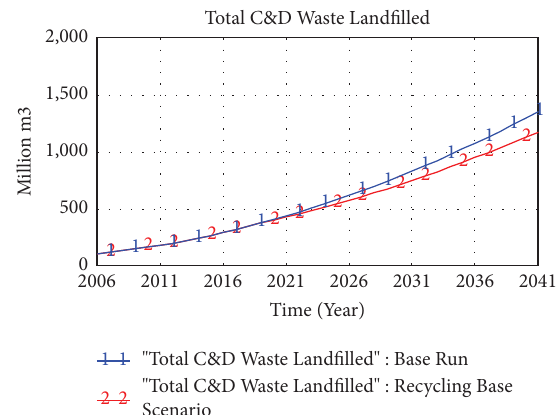
Figure 11: Te trend of landflled C&D waste for both